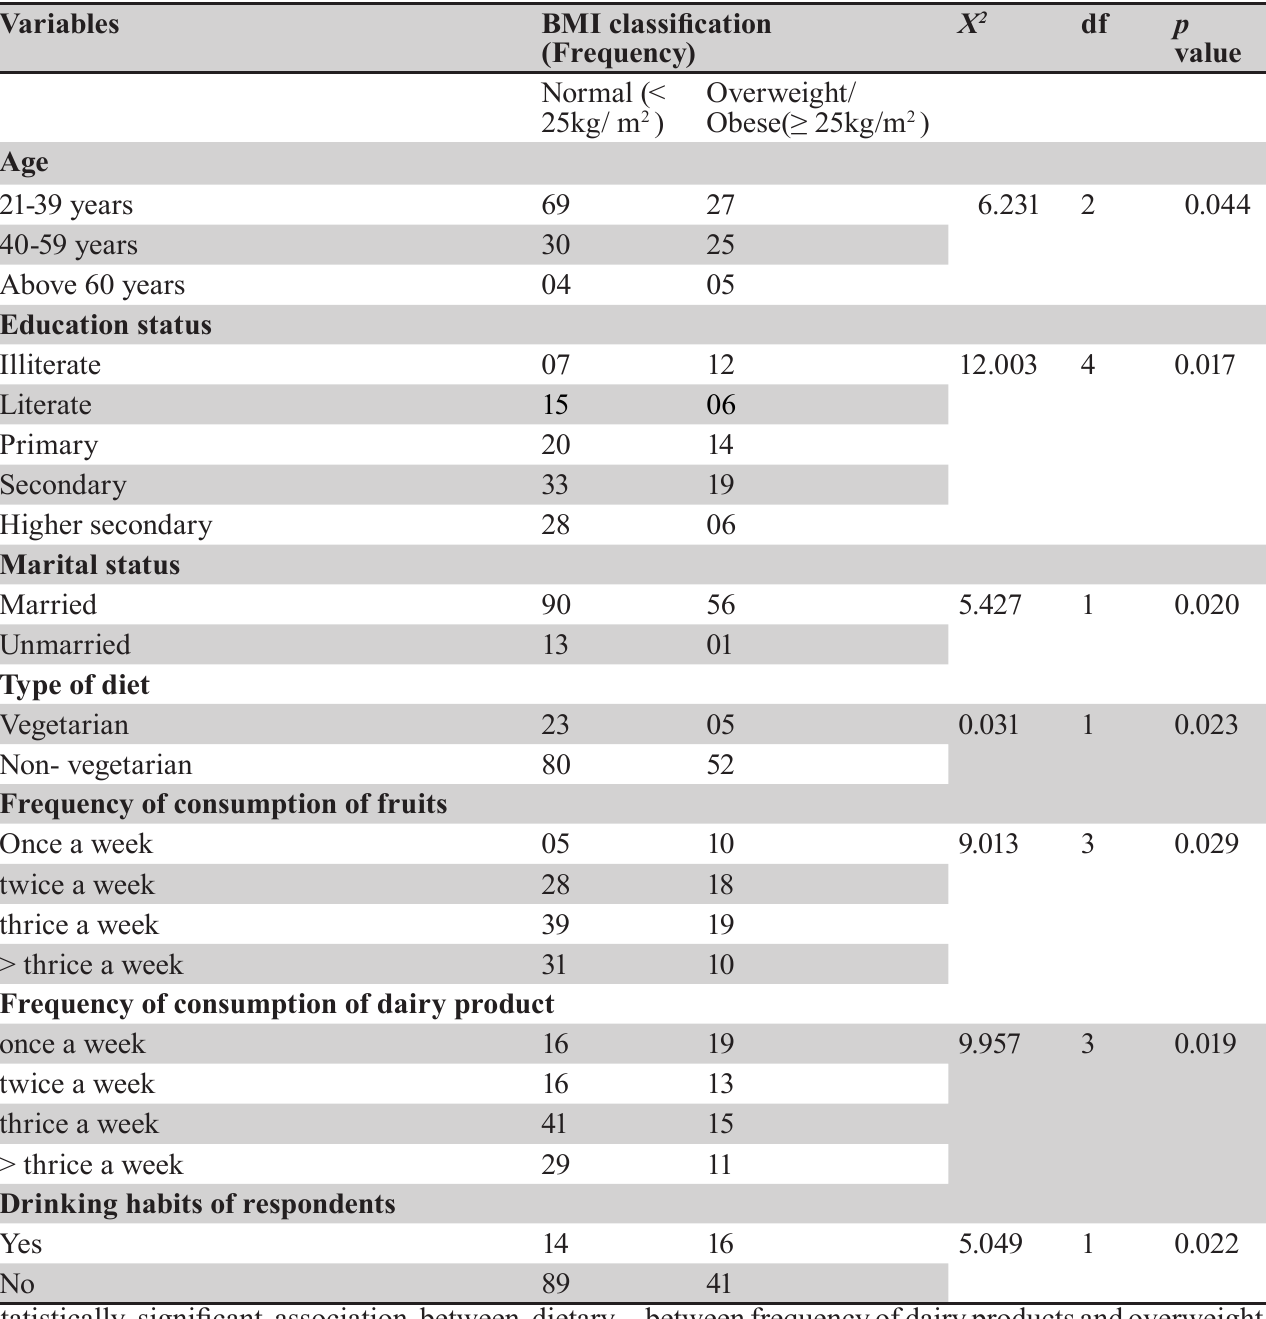
Table 3: Association between socio-demographic variables and respondent’s BMI (N=160)